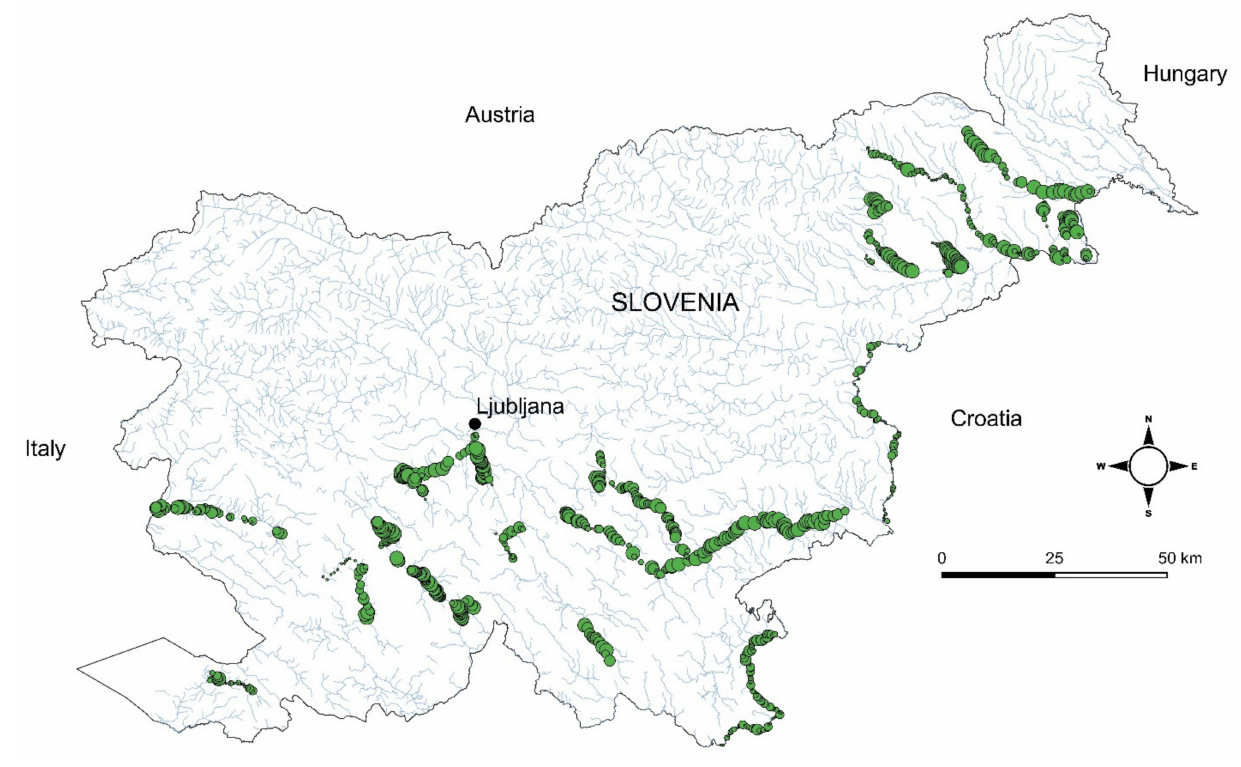
Figure 2. Relative abundance of macrophyte species presented as size of the circles in the stretches of the surveyed